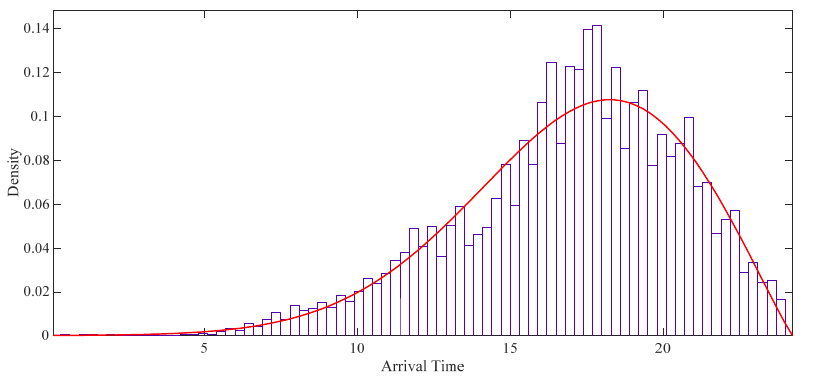
Figure 2. Probability distribution function (PDF) of arrival time.